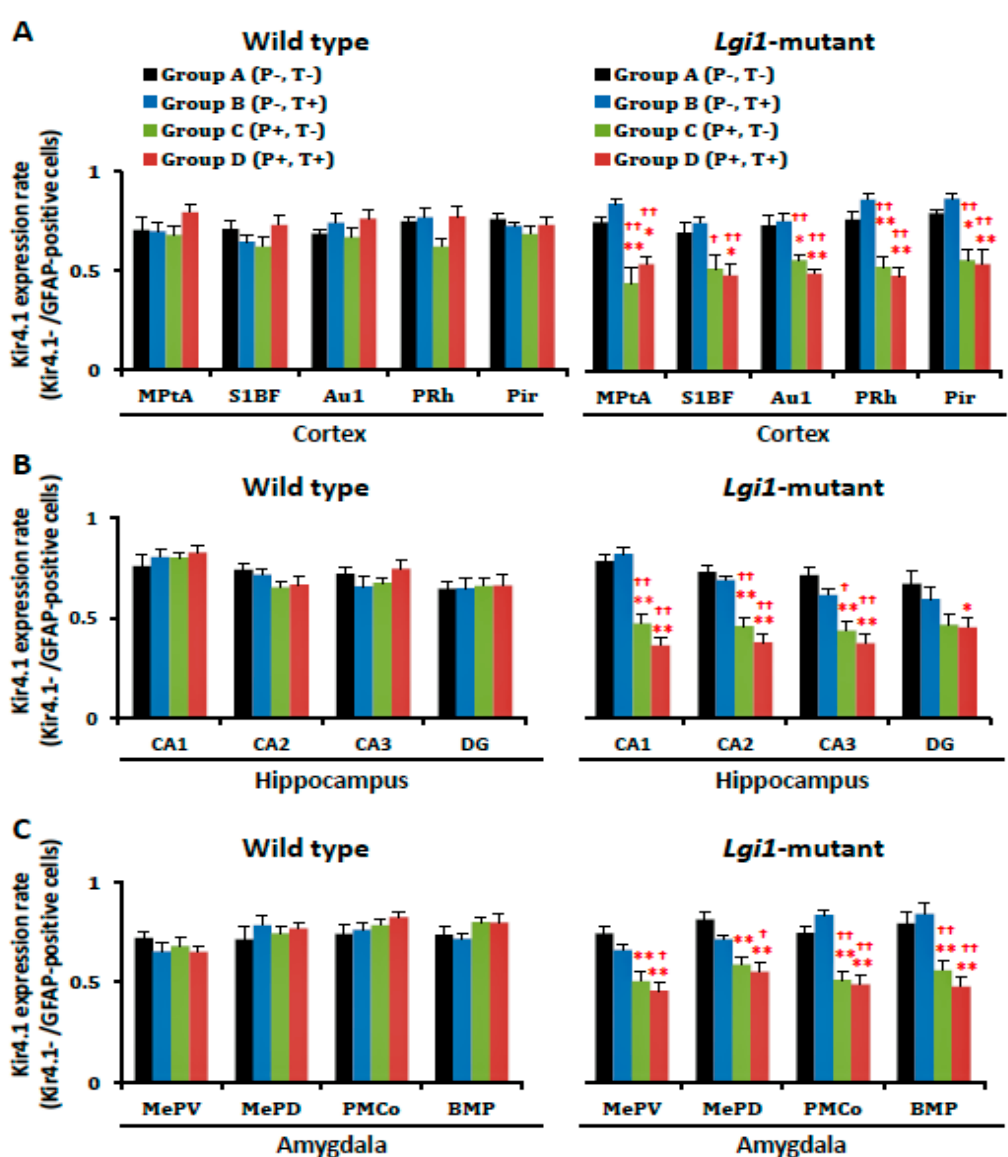
Figure 5. Changes in astrocytic Kir4.1 expression after the development of audiogenic epilepsy. The Kir4.1 expression rate in each group of wild-type rats ( A – D ) and Lgi1 mutant rats are shown in each region of the cortex ( A ), hippocampus ( B ), and amygdala ( C ). The Kir4.1 expression rate was expressed as the ration of Kir4.1-immunoreactivity (IR)-positive cells to GFAP-IR-positive cells in each region by staining a pair of successive brain sections with anti-Kir4.1 or anti-GFAP antibodies. Each point represents the mean ± S.E.M. of six to eight animals. * p < 0.05, ** p < 0.01, significantly different from Group A of wild-type rats and Lgi1 mutant rats. † p < 0.05, †† p < 0.01, significantly different from Group B of wild-type rats and Lgi1 mutant rats.